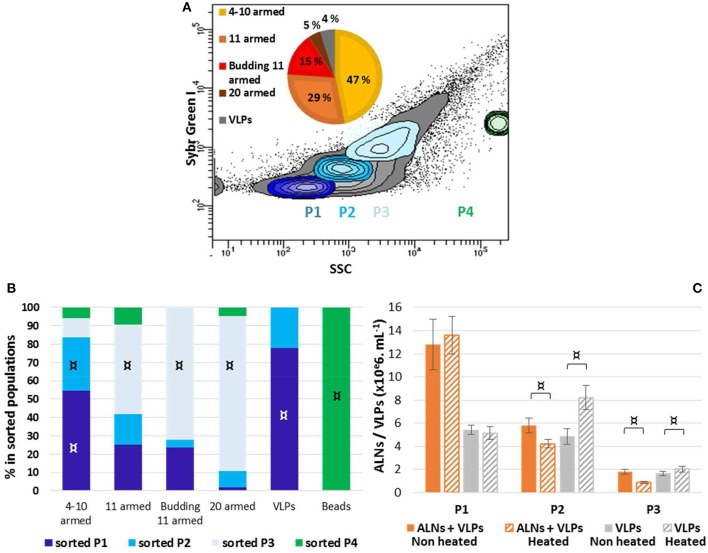
Flow cytometry analysis of aster-like nanoparticle-enriched preparations (E-ALNs). (A) Gating of three distinctive populations (P1, P2, P3) of SYBR Green-stained E-ALNs. Heating was omitted during the staining procedure, and beads (0.5 μm) were used as control fraction (P4). The gray area in scatter plot including in P1, P2, and P3 commonly represents VLP fractions (see Brussaard, 2004). A pie chart shows the relative proportions of ALNs morphotypes attested by TEM. (B) Distribution of ALNs morphotypes and beads in the four FACS-sorted fractions counted by TEM. (C) Cytometry counts of P1, P2, and P3 gated fractions compared to counts obtained when heating was included in the SYBR Green staining procedure, and to counts of particles in ALNs-free viral community stained in heat-driven conditions. Mean values from triplicate and standard errors are plotted. Significant representativeness of morphotypes in sorted populations (B) is indicated by symbols: ¤ (Fisher's exact test on a contingency table, p < 0.01). Significant differences between “non-heated” and “heated” conditions (C) are indicated by an symbol ¤ (Student T-test, p < 0.05).